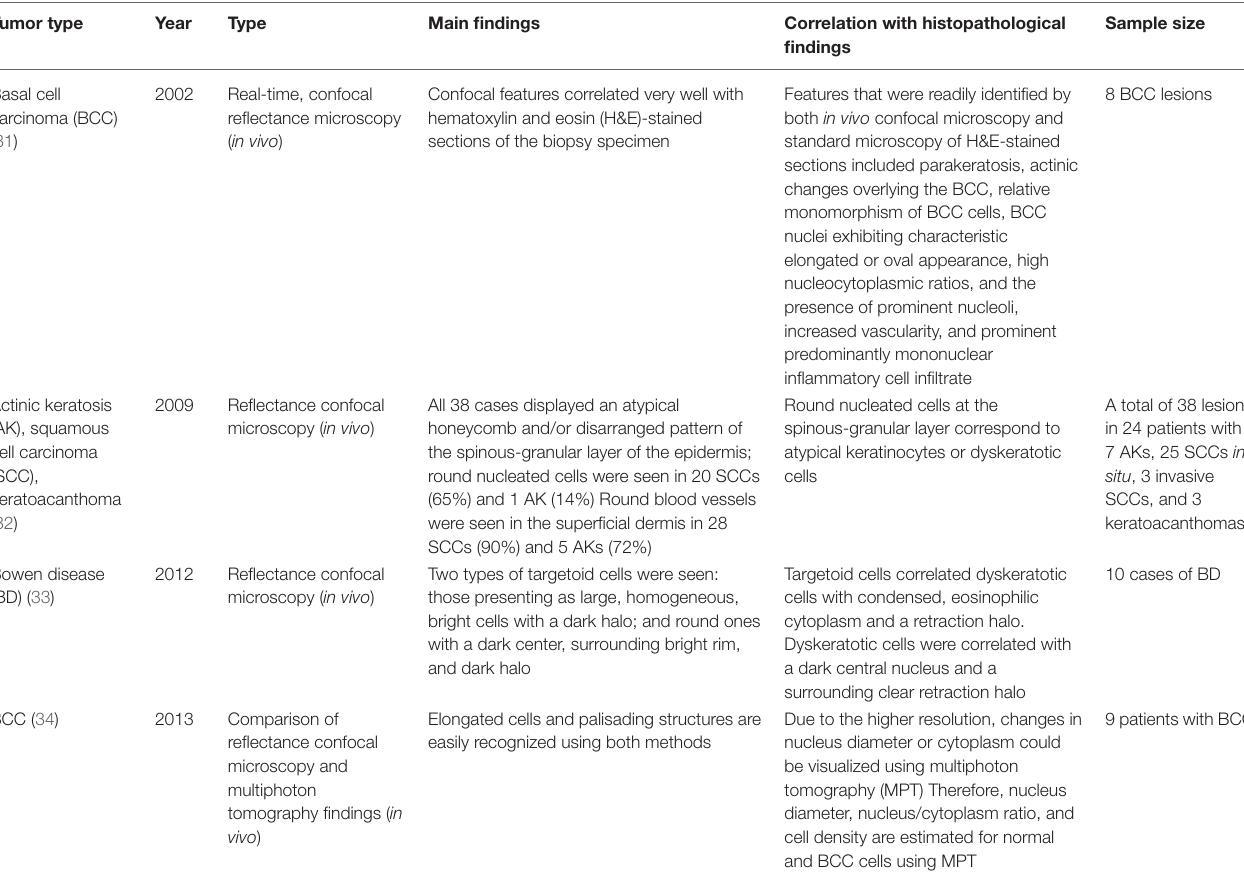
TABLE 5 | Key articles comparing confocal microscopy and histopathology. Tumor